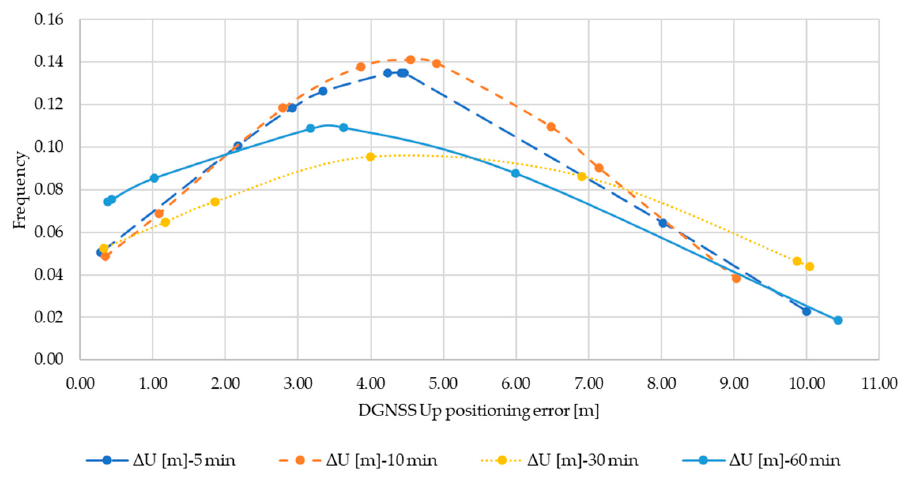
Figure A3. Normal distribution Δ U for DGNSS.